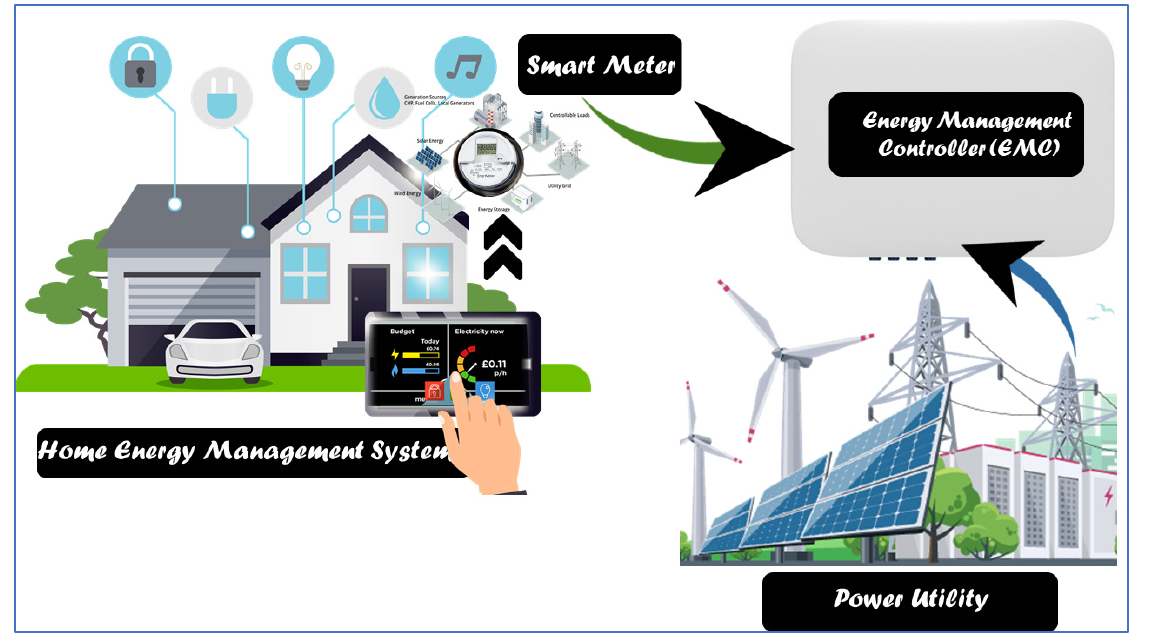
Figure 3. Proposed energy management system architecture. Table 3. Parameters of appliances.